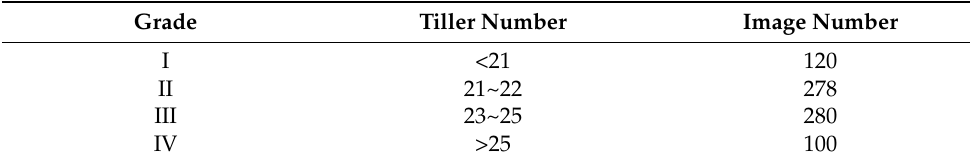
Figure 6. Some image examples of four tiller number grades (improved brightness). Table 1. Dataset details.